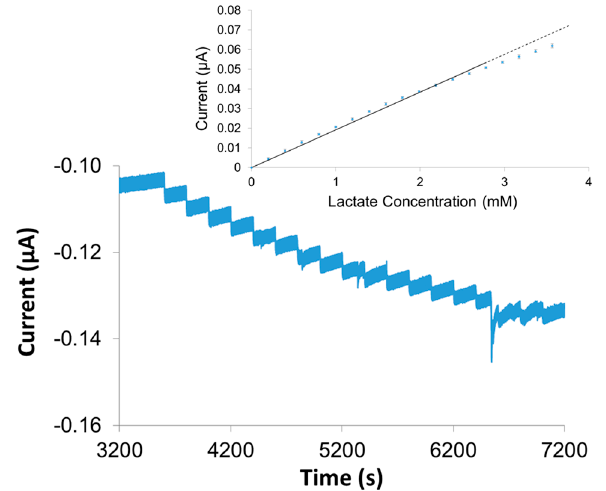
Figure 9. Typical amperometric I − t curve and corresponding calibration curve during successive 0.2 mM injections of lactate at Pt-Ir wire modified with electrochemically-deposited pyrrole layer, LOx and BSA-doped HMTES xerogel, polyurethane layer (100% PU) capping layer, and epoxy cap tested in blood serum. Notes: Amperometric responses have been normalized to compensate for rising background charging current; error bars represent standard deviation of the mean (n ≥ 3).